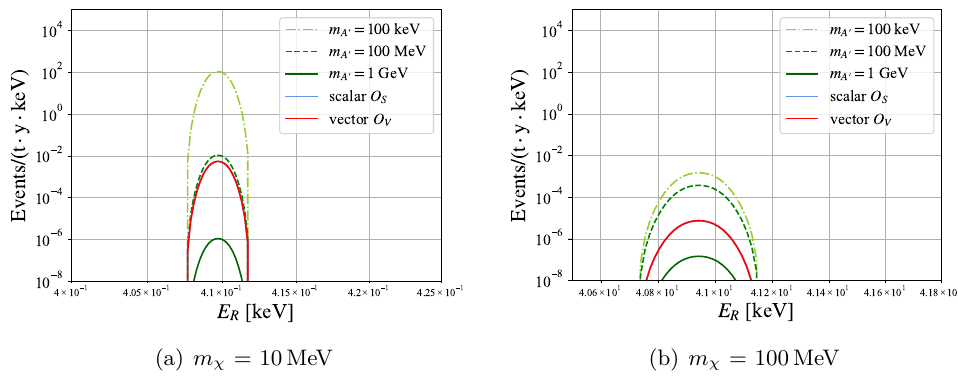
Figure 3 . Differential scattering rates of target 131 Xe for some masses of DM and dark photon. The coupling e 2 U 2 in eq. (3.3) is fixed to be 10 − 50 cm 2 . The differential rates of the scalar and vector interactions with 1 / Λ 2 = 10 − 50 cm 2 in ref. [10] are also shown for reference. where p is neutrino momentum and U is defined as U = µ ν